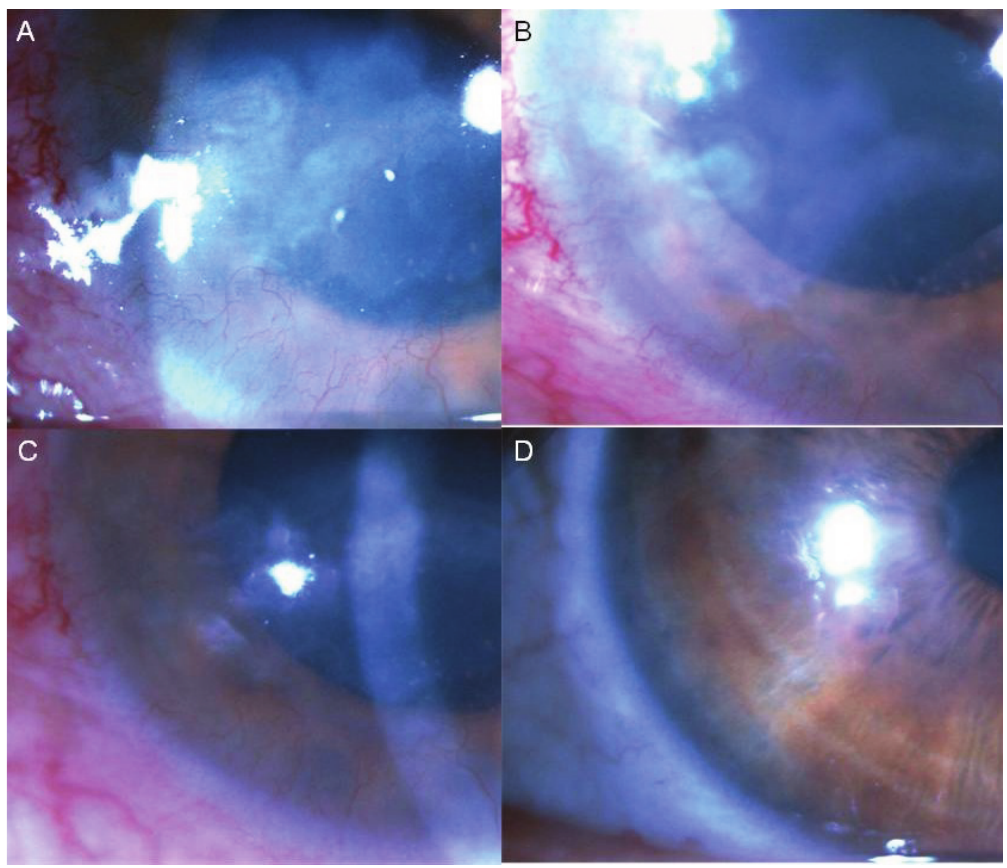
Figure 3. The significant decrease in corneal vascularization and haziness scores after addition of topical tacrolimus eye drops 0.05% at baseline (A), and after 1 week (B), 2 weeks (C), and 4 weeks (D).